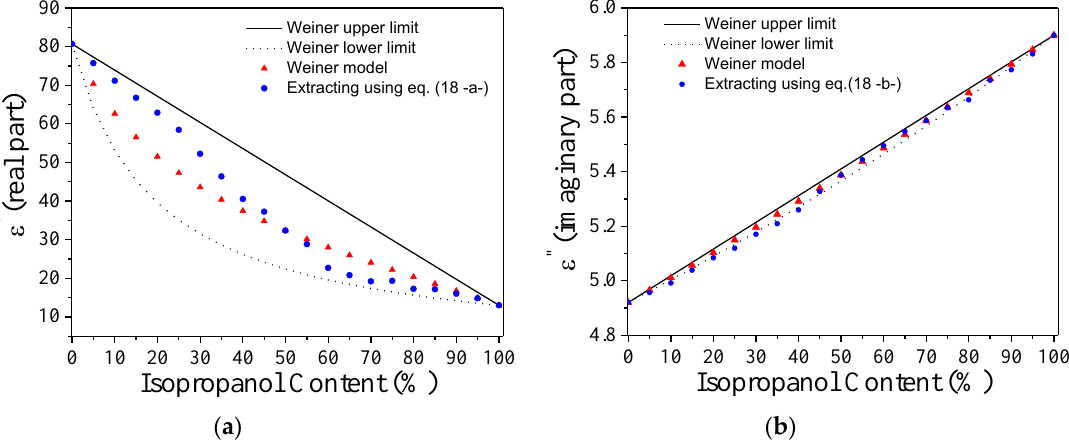
Figure 31. Real ( a ) and imaginary ( b ) parts of the complex dielectric constant for the different solutions of isopropanol in DI water. From [64], reprinted with permission.